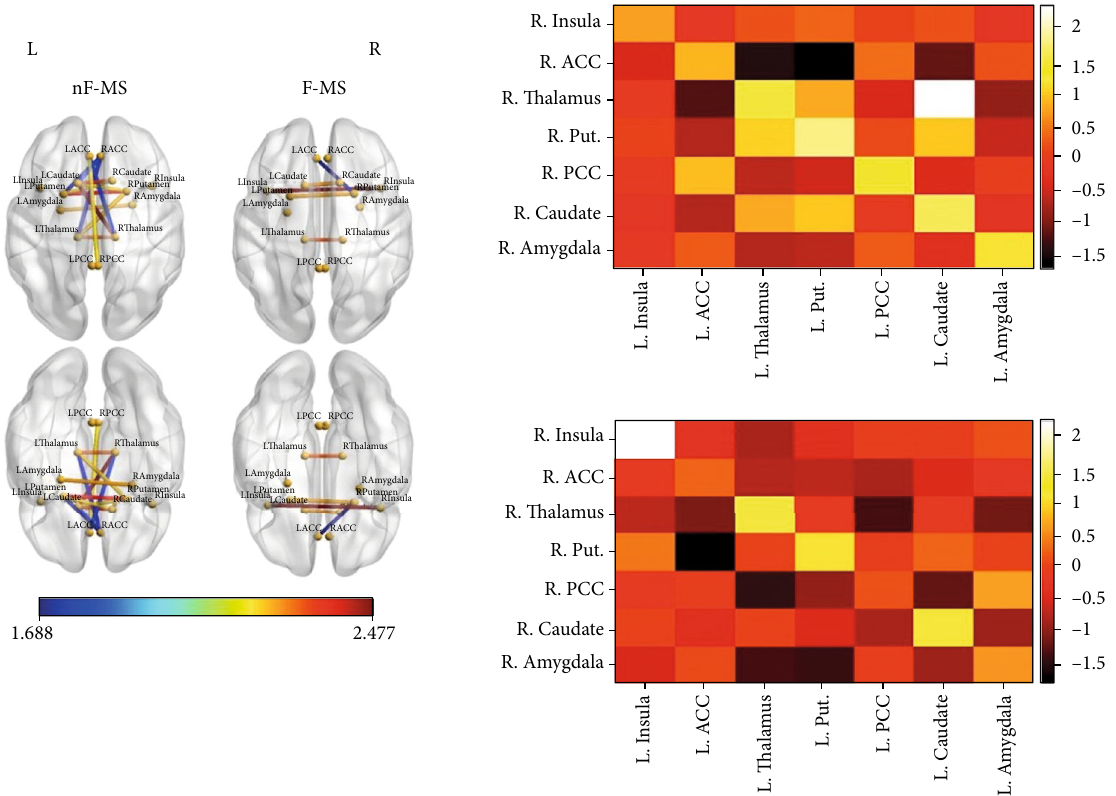
Figure 2: Results from the anatomical covariance analysis (ACA). The left column of glass brains belongs to the nF-MS group. The right column of brains belongs to the F-MS group. Blue lines indicate inverse correlations between the di ff erent volumes of interest (VOIs). Yellow and red indicate positive correlations between the VOIs. The color bar represents Fisher Z scores. Only signi fi cant correlations are presented. The right side of the fi gure shows the matrices of correlations between right and left VOIs. The up-right matrix belongs to the nF-MS group. The down-left matrix belongs to the F-MS group. L: left: R: right. The color bar of the matrices represents the Fisher Z